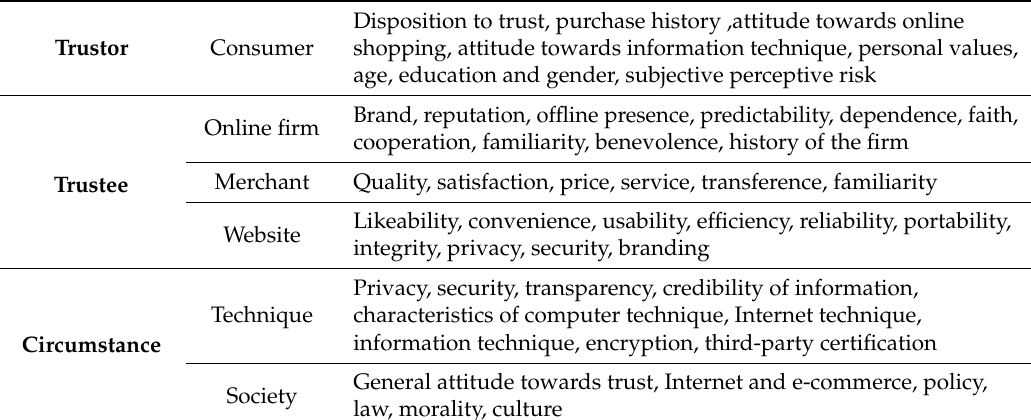
Figure 1. The components of trust system chart of business-to-consumer (BtoC) e-commerce. Table 1. Components of the trust system of BtoC